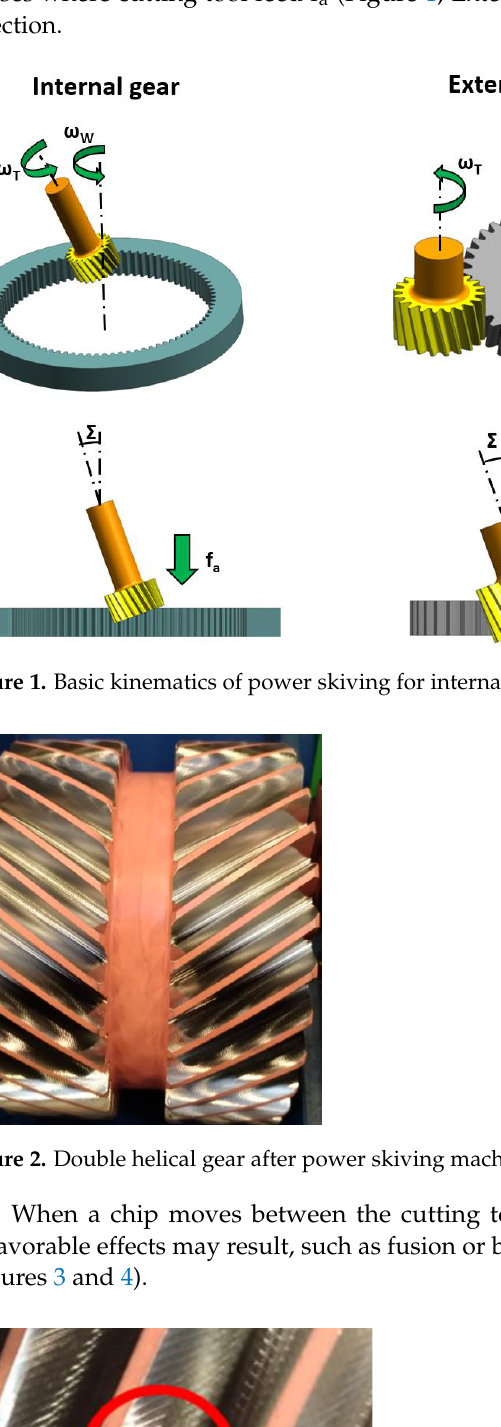
Figure 3. Bound chip on the tooth involute surface, after power skiving machining.